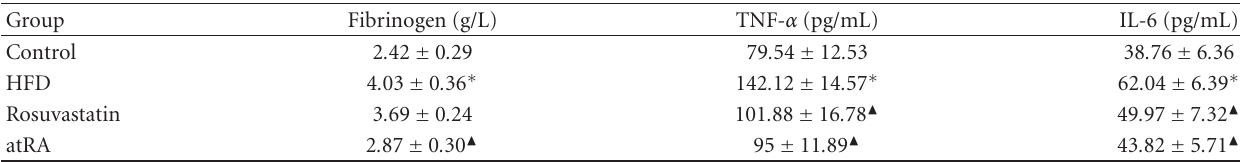
Figure 3: Platelet CD62-P expressions in di ff erent groups. Isolated platelets were incubated with FITC-labelled anti-CD62P antibody, and surface CD62-P changes were monitored by flow cytometry. Representative histograms from every group are shown. (a) The expression of CD62-P on the resting platelets surface from di ff erent groups. (b) The expression of CD62-P on the thrombin-activated platelets from di ff erent groups. (c) The expression of CD62-P on the ADP-activated platelets from di ff erent groups. (d) Mean fluorescence intensity (MFI) of CD62-P expression on platelets surface in di ff erent groups. Data are mean ± standard deviation (SD). Comparisons between groups were carried out using one-way analysis of variance (ANOVA) and Student-Newman-Keuls (SNK) method ( n = 6). ∗∗ P < 0 . 01 compared to control group, (cid:2) P < 0 . 05, (cid:2)(cid:2) P < 0 . 01 compared to HFD group. Table 2: Levels of fibrinogen and cytokines in di ff erent